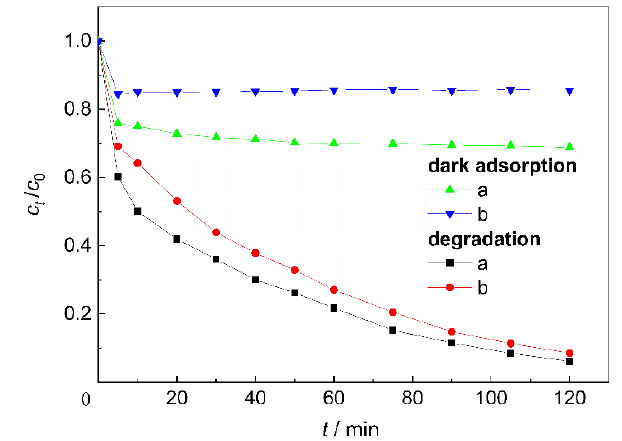
Figure 4. Effect of bone char size of ZnO/bone char on the dark adsorption and degradation of methylene blue.